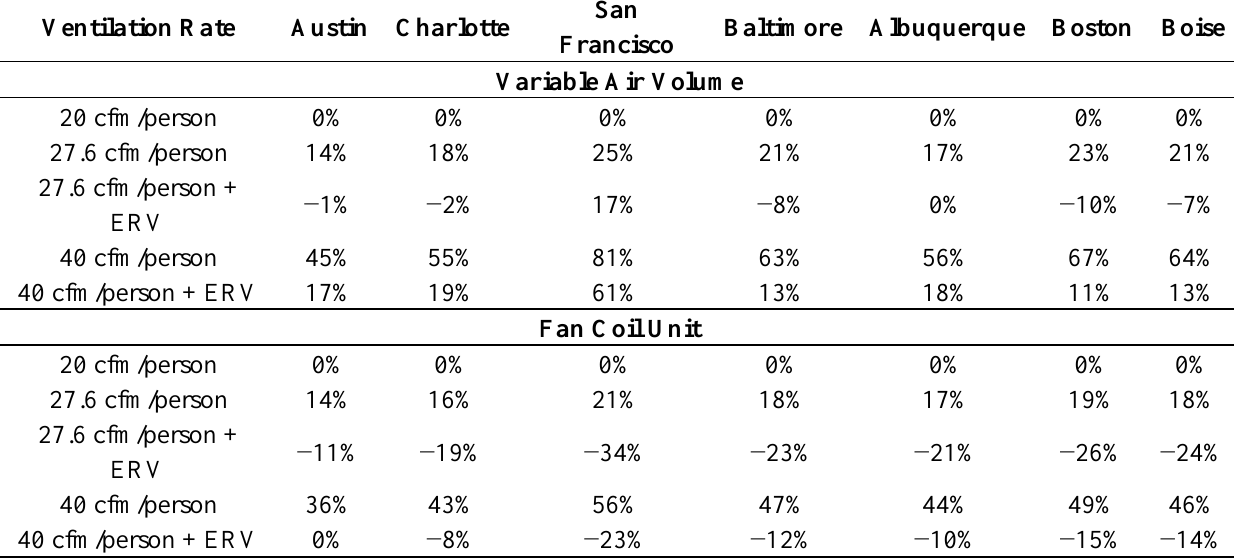
Ventilation Rate